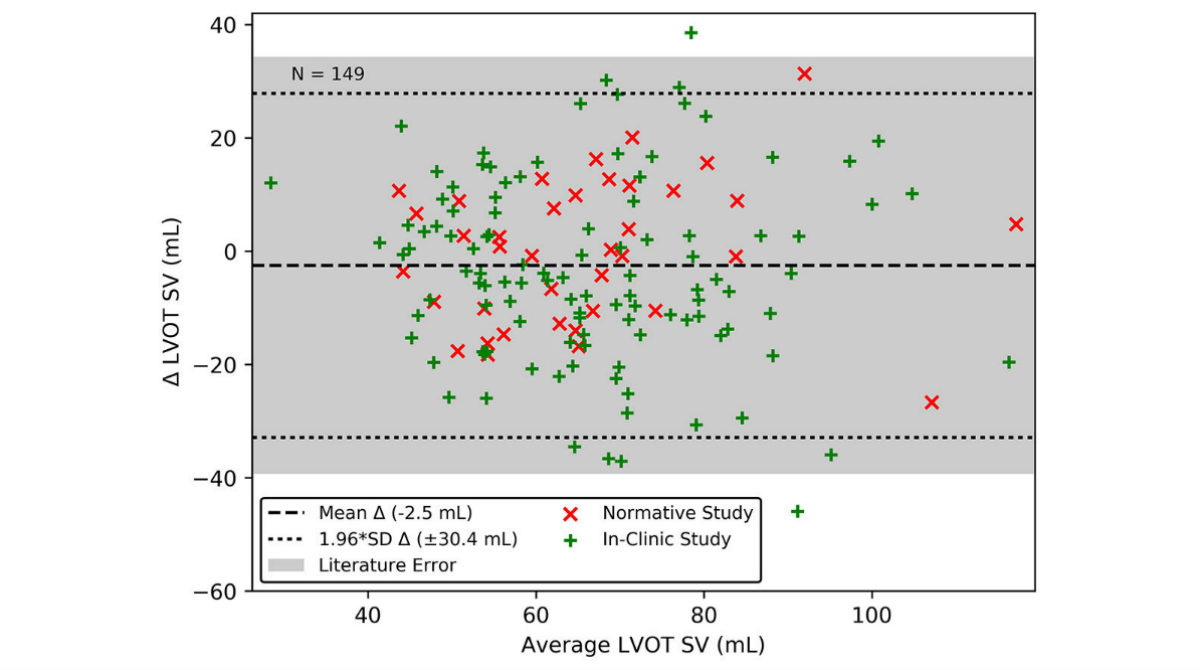
Figure 7. The seat estimate of stroke volume (SV) strongly correlates to the echocardiography measure of SV measured from the left ventricular outflow tract (LVOT). In comparison, the literature shows that the echocardiogram SV measure has a limits of agreement of 35.2 mL (shaded region) compared to an arterial gold standard.